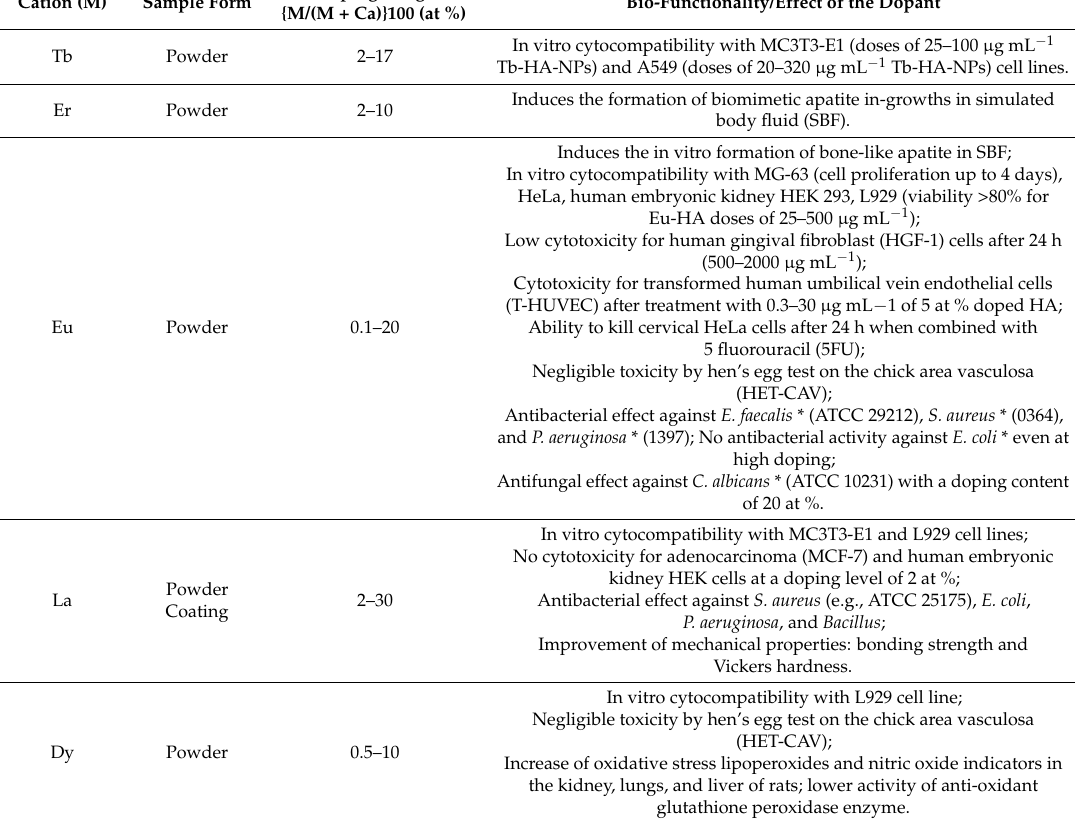
Table 1. Synopsis of the realm of bio-functionality of cation-substituted hydroxyapatites (Has) [36]. Cation (M) Bio-Functionality/Effect of the